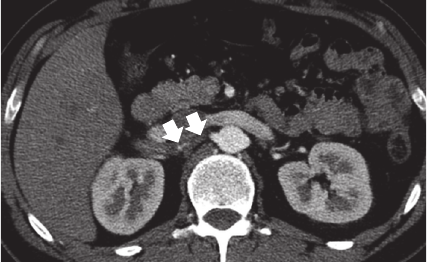
Figure 4: Contrast-enhanced CT scan, axial image, arterial phase shows intraluminal subtotal filling defect due to a thrombosis of a branch of the triple renal artery (arrows) from the origin up to its most peripheral